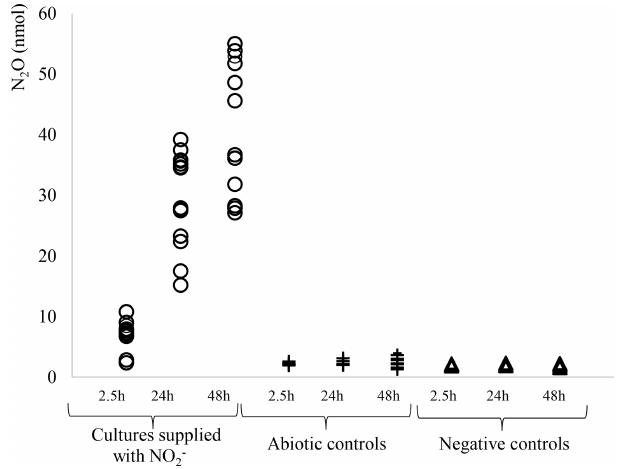
. N 2 O synthesis 2